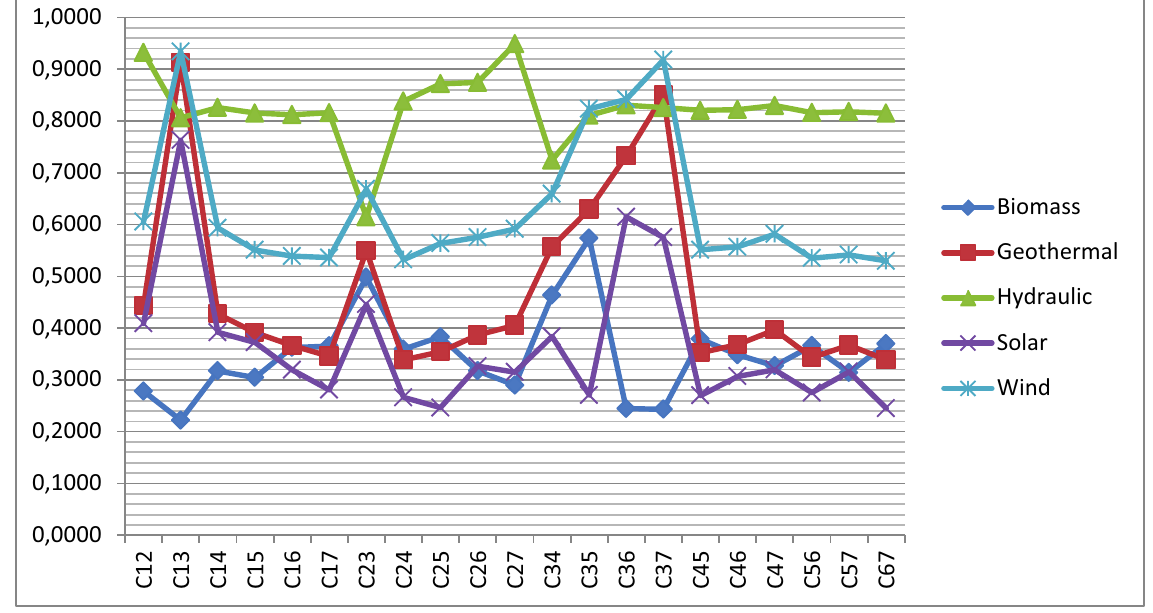
Fig. 3. Sensitivity